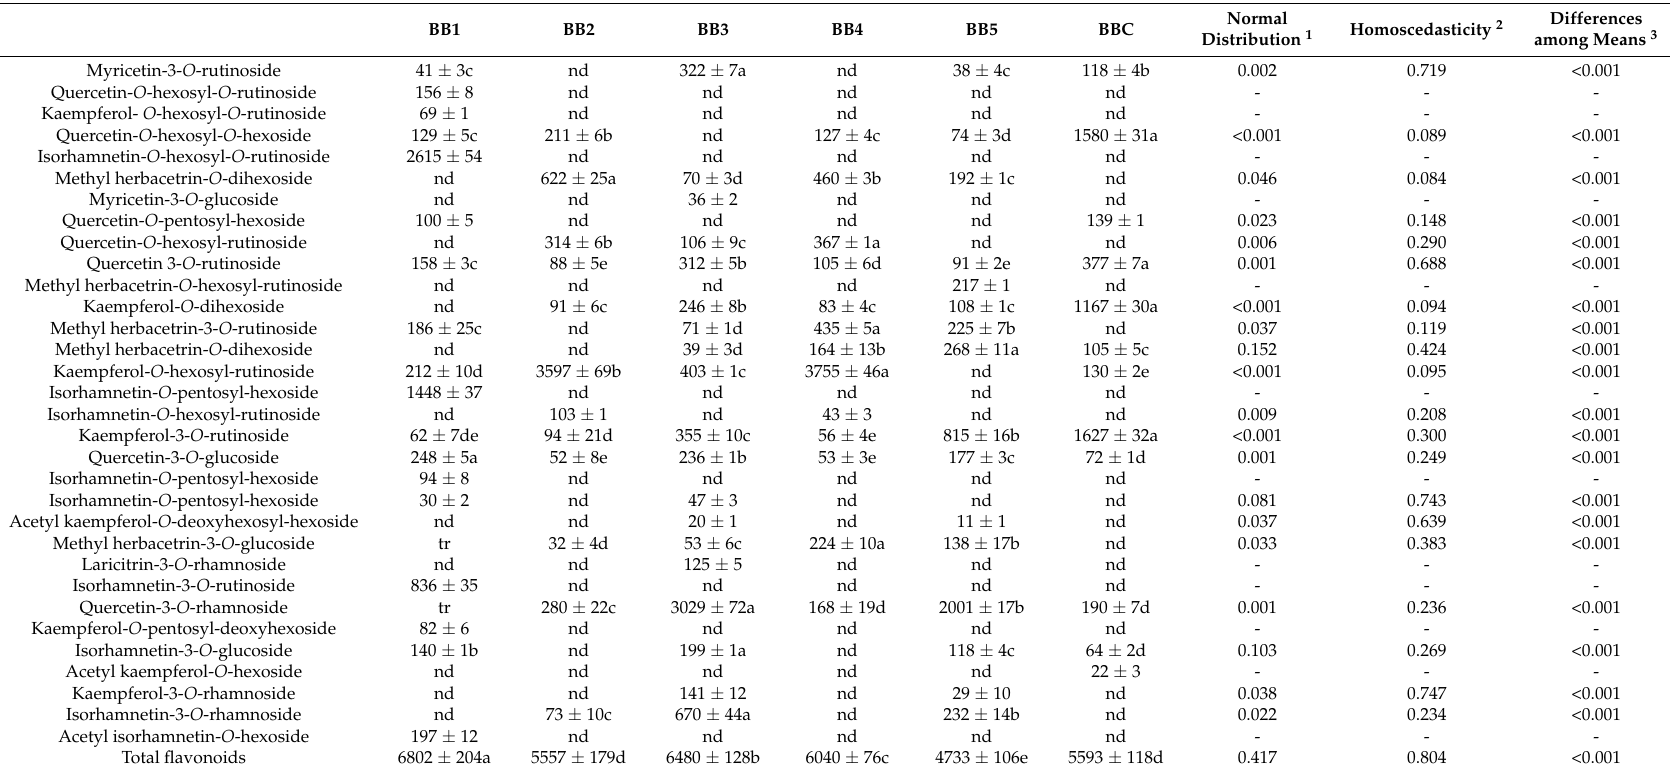
Table 2. Quantification of the phenolic compounds ( µ g/g of extract) present in the bee bread